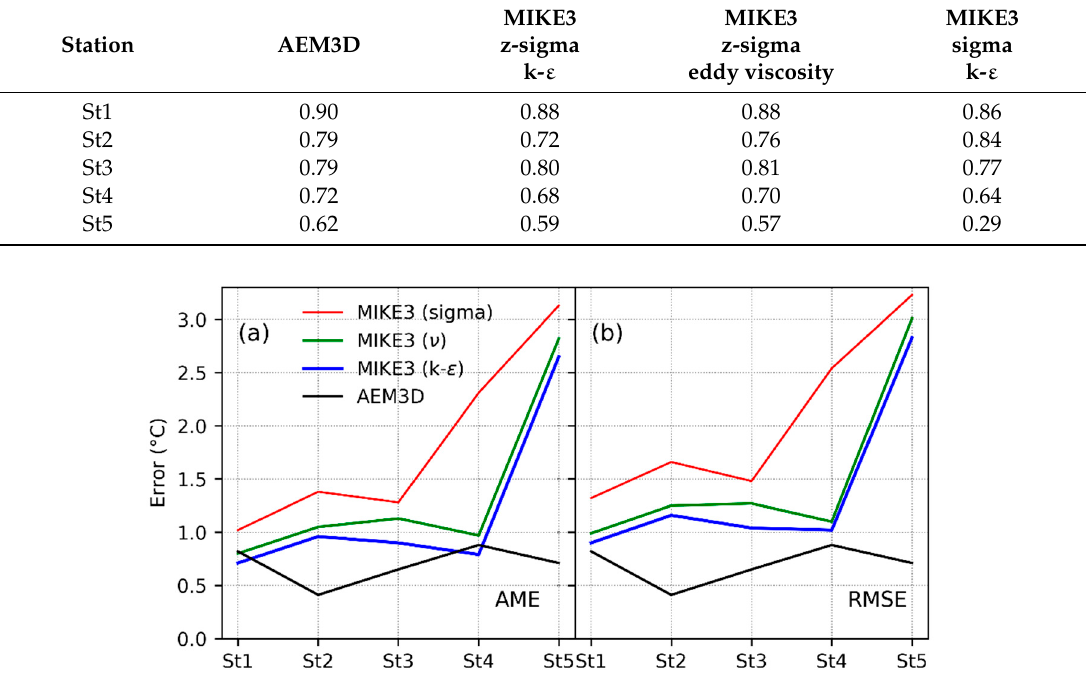
Table 4. Correlations between models and measured data at di ff erent stations.